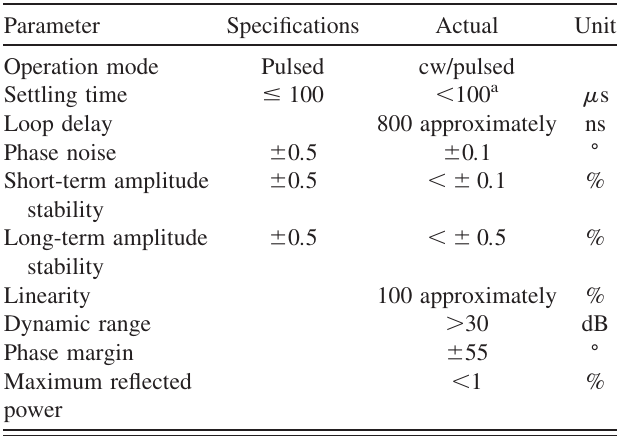
TABLE II. LLRF performance summary.